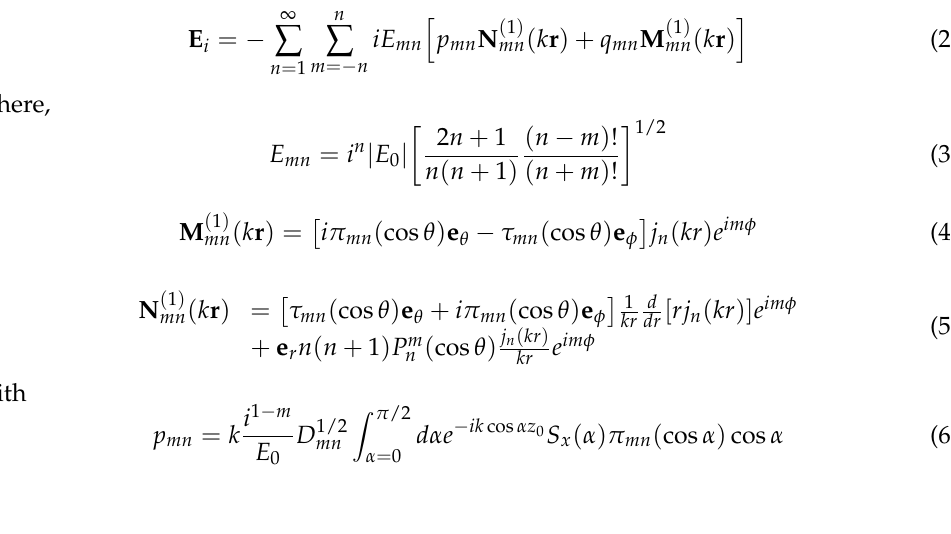
Figure 1. Distribution of radiation force component F z under the illumination of Bessel pincer light-sheets beam( λ = 0.6328 µ m, α 0 = 0.5 and l = 10) on the dielectric sphere (radius is 0.1 µ